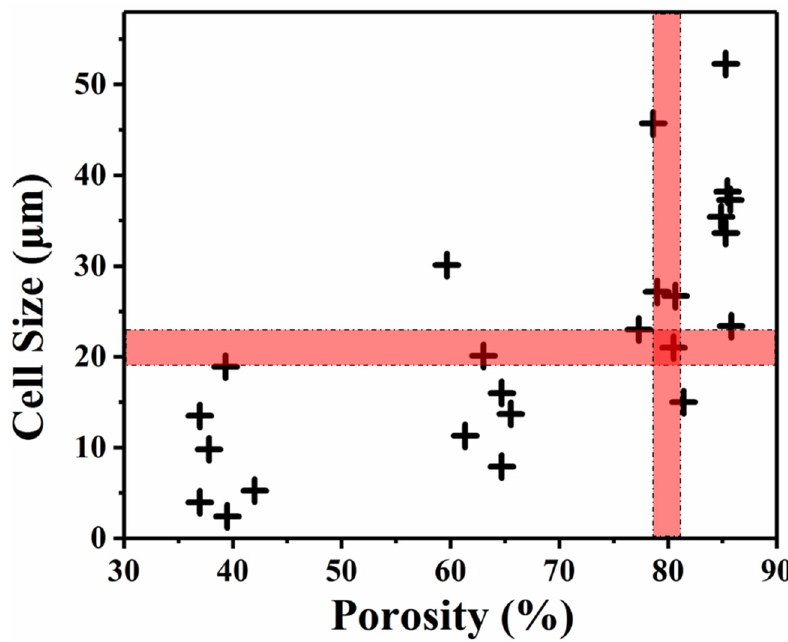
Figure 5. Cell size of foamed sample with a relationship of its porosity.